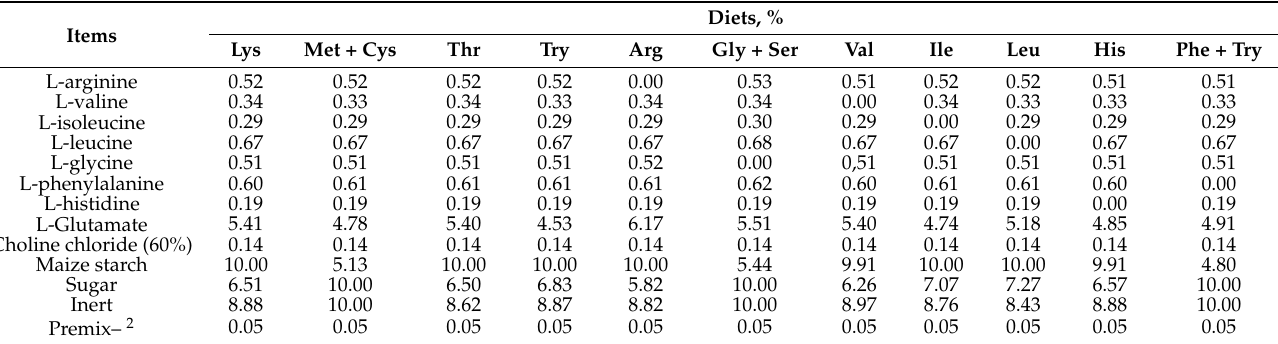
1 Table 1; 2 Content per kg of the diet-vit A 6.668 IU; vit D3 1.668 IU; vit E 8 IU; vit K 3.2 mg; vit B1 1 mg; vit B2 3.34 mg; vit B6 2 mg; vit B12 5 mcg/kg; niacin 21 mg; chlorine 0.13 g; pantothenate acid 8 mg; folic acid